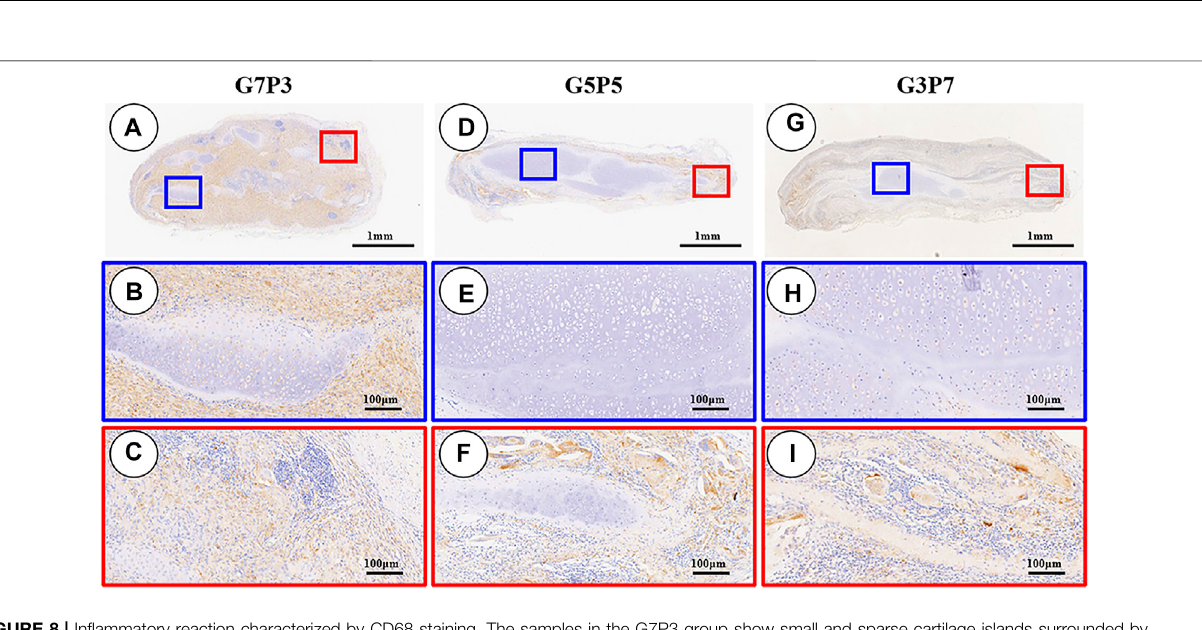
Frontiers in Bioengineering and Biotechnology |